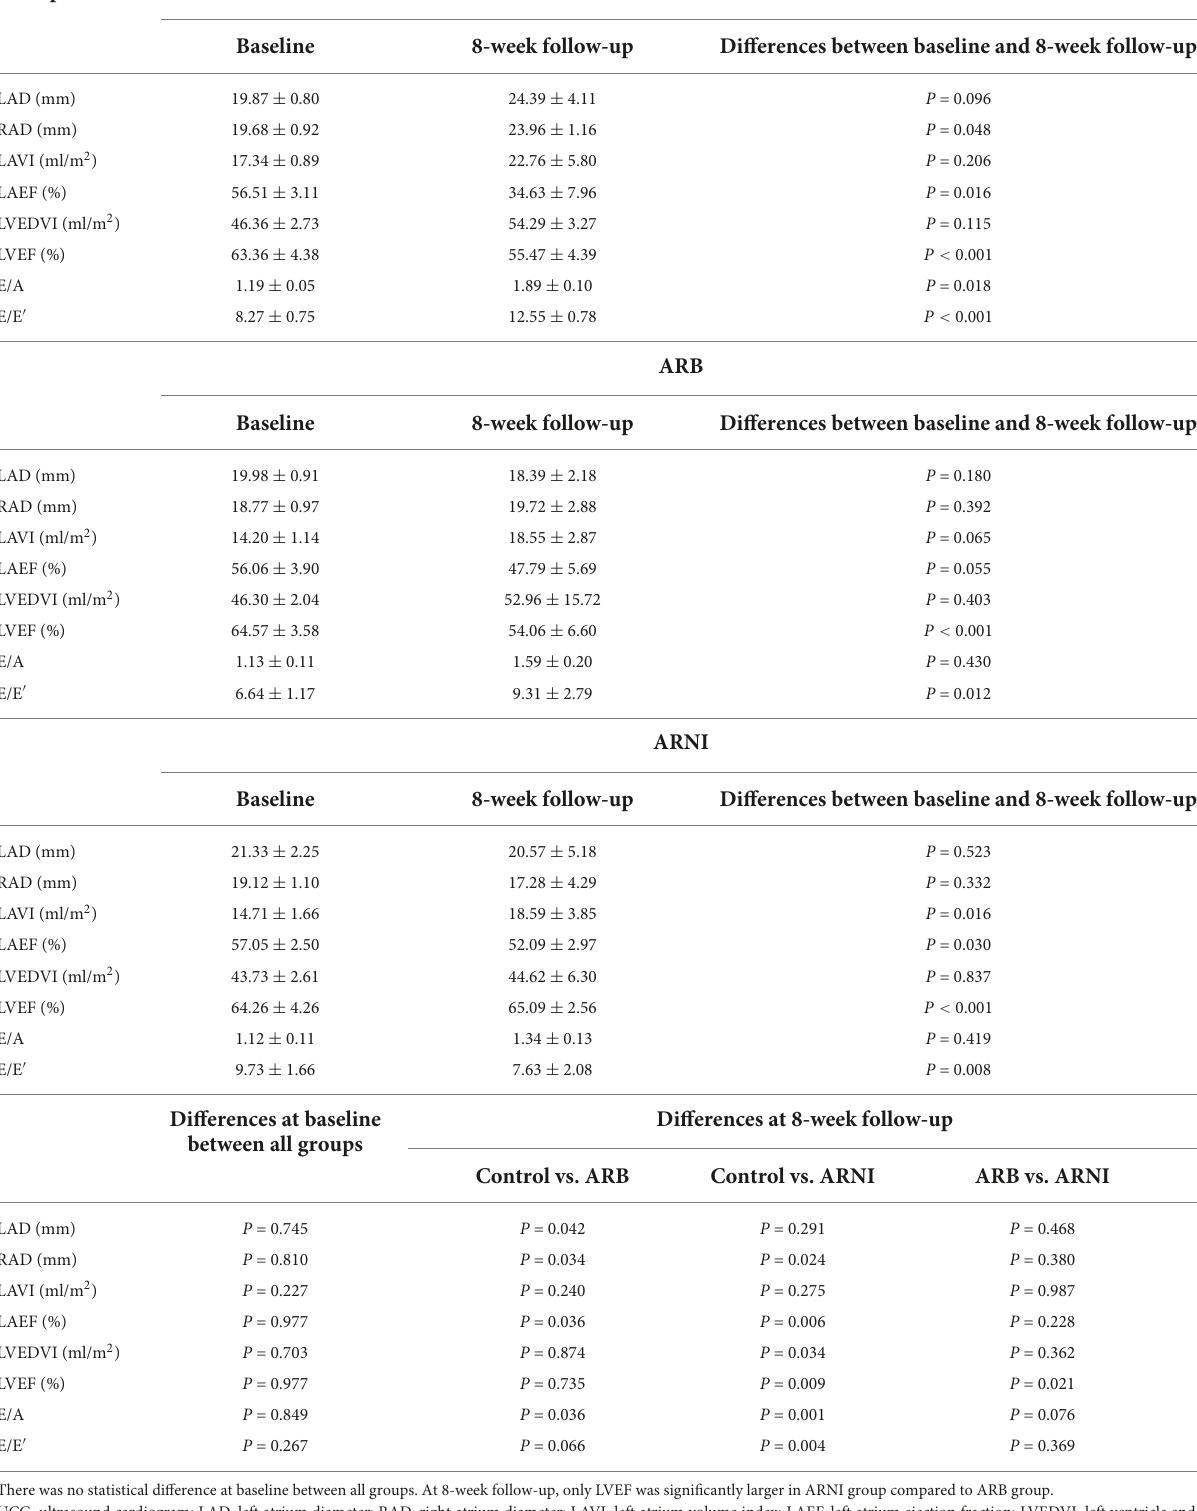
TABLE 5 Ultrasound cardiogram parameters in all animal